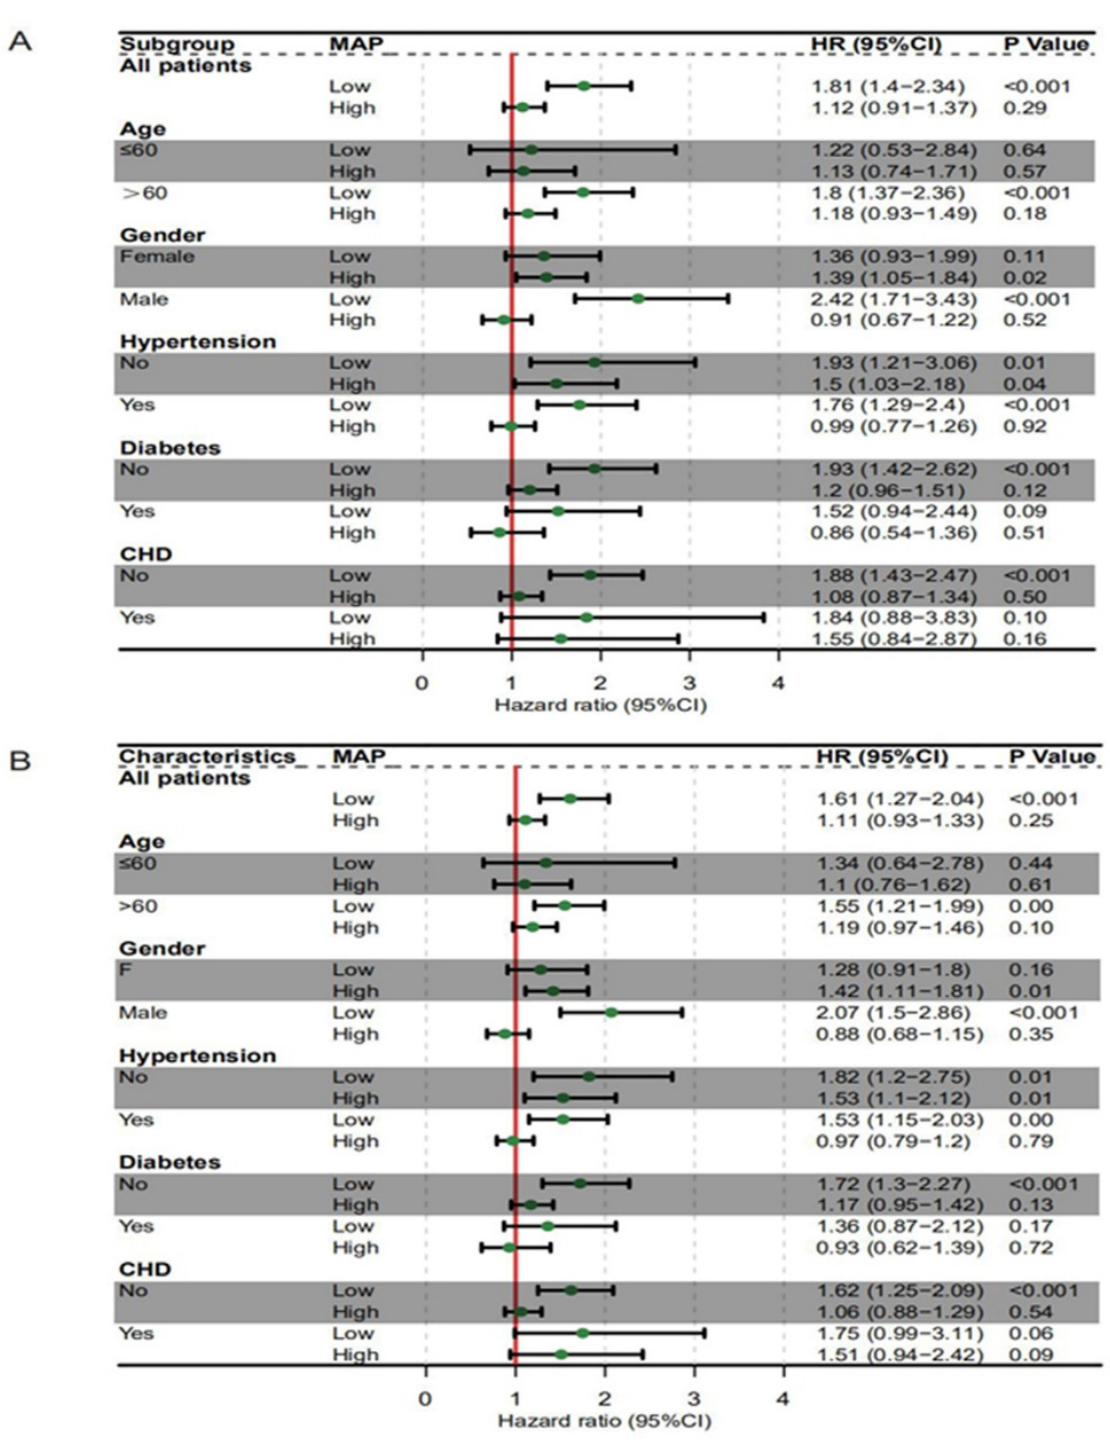
Figure 4. Subgroups analysis of the 7-day mortality ( A ) and 28-day mortality ( B ) according to different MAP ranges. The multivariable Cox regression model adjusted for all the covariates was performed to calculate the hazard ratio and 95% CI.